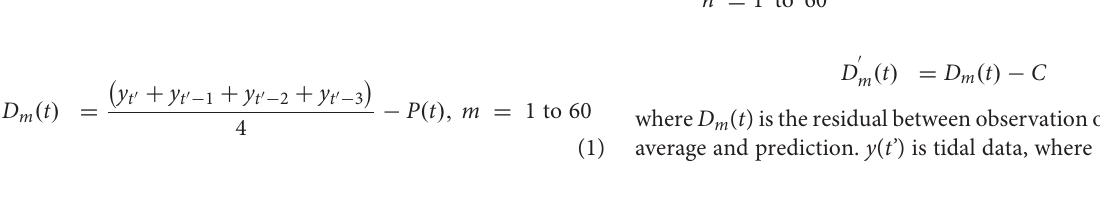
from D m shown in Eq. (3). By subtracting the average value of